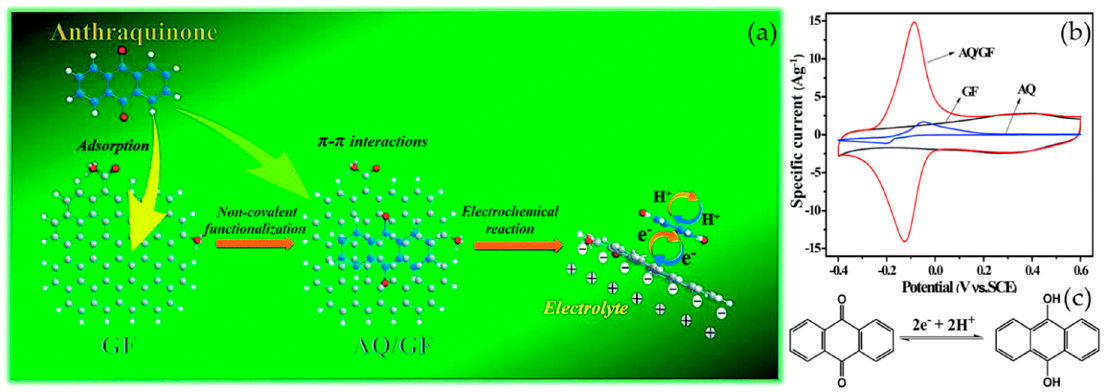
Figure 10. ( a ) Schematic illustration of AQ/GF composite; ( b ) CV curves of AQ, GF and AQ/GF; ( c ) The corresponding redox reactions by a coupled proton–electron transfer. Reproduced with permission from [104]. The Royal Society of Chemistry (2015).